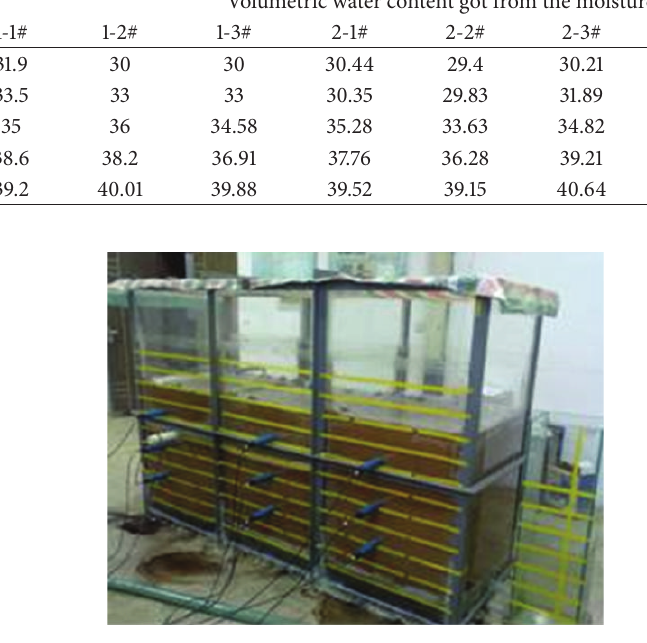
Table 2: Conversion relationship of mass and volumetric water content got from the moisture probes. Mass water